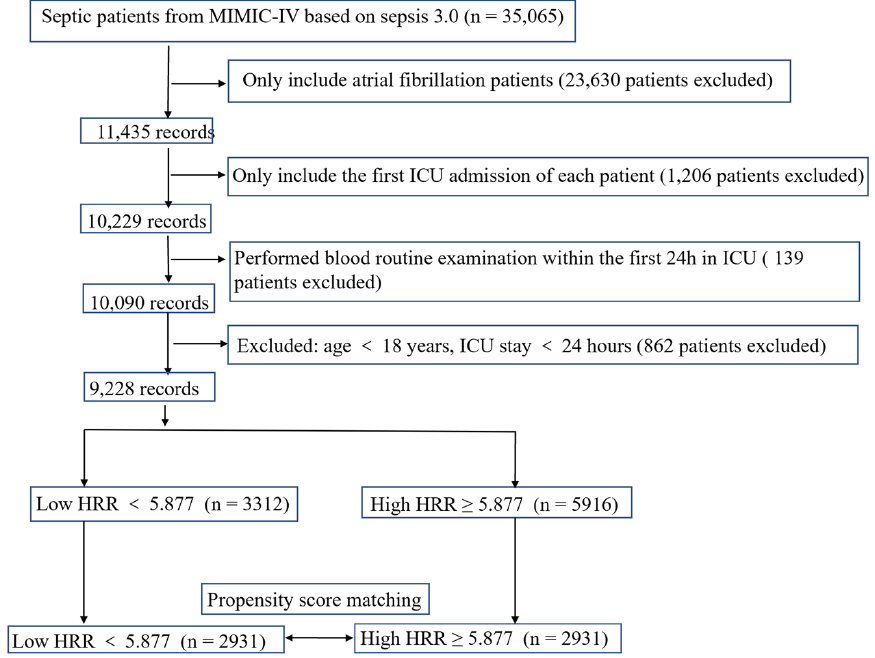
Figure 1. The flow chart of the study.